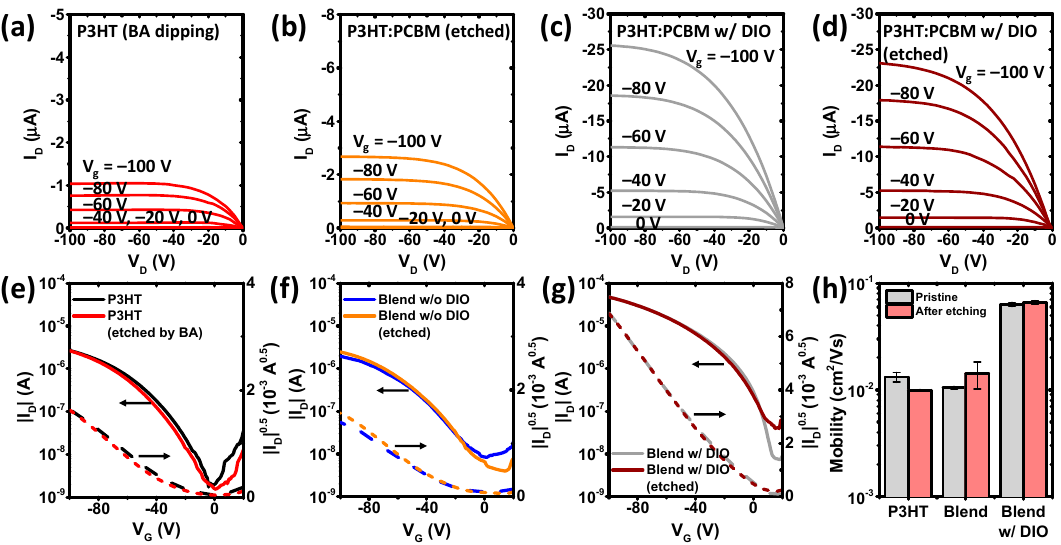
Figure 5. Comparison of organic thin film transistor (OTFT) characteristics of P3HT and P3HT:PCBM blends, with and without wet-etching process. ( a – d ) Output curves of ( a ) P3HT after BA dipping, ( b ) P3HT:PCBM after etching, ( c ) P3HT:PCBM with DIO without etching, and ( d ) P3HT:PCBM with DIO after etching. ( e – g ) Transfer curves of ( e ) P3HT, ( f ) P3HT:PCBM, and ( g ) P3HT:PCBM processed with DIO. ( h ) Field-e ff ect hole mobility of the devices. Device testing conditions: W / L = 10 and V D = − 100 V.